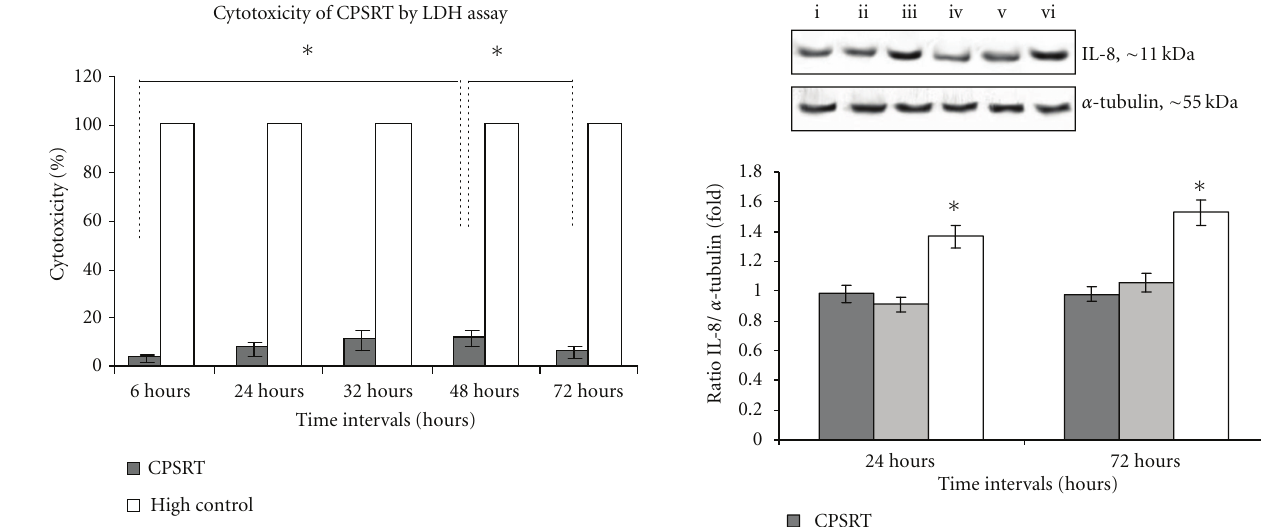
Figure 2: Cytotoxicity of CPSRT as determined by the release of LDH from the damaged cells. n = 5, ∗ for P ≤ 0 . 05.